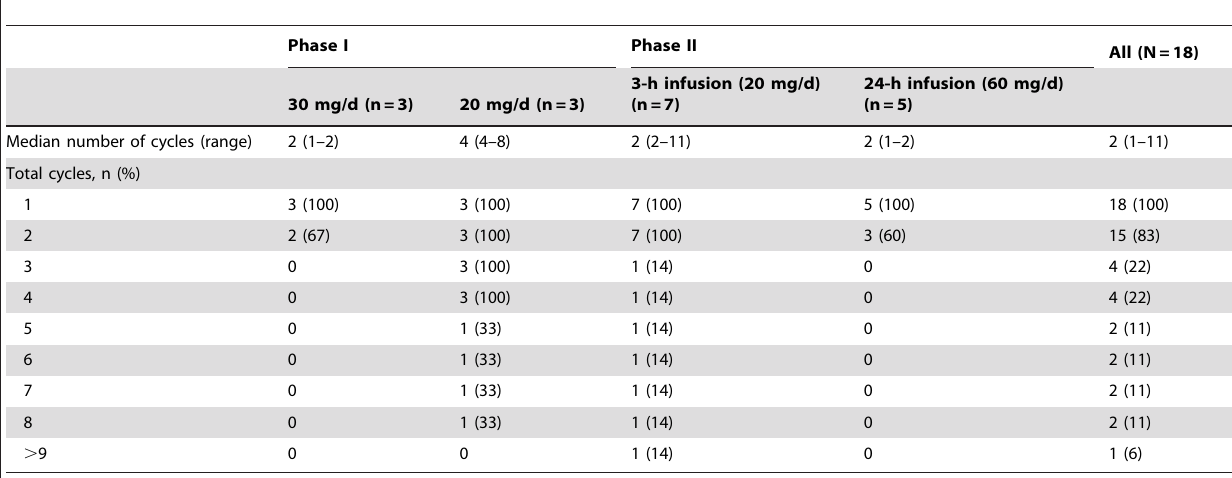
Table 2. Study drug exposure in patients treated with obatoclax (N